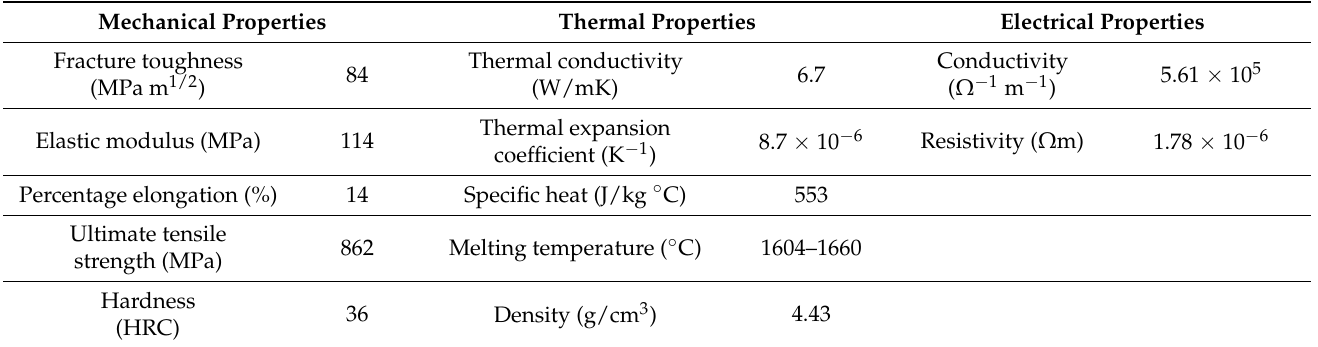
Table 2. Physical, electrical, and thermal properties of the workpiece Ti6Al4V alloy (open access CC BY-NC-ND 4.0